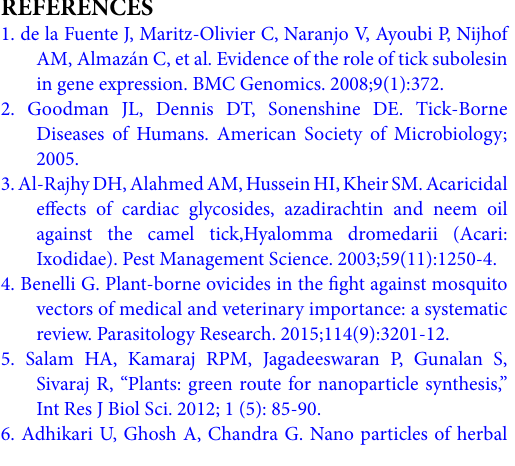
237 Nanomed Res J 4(4): 234-238, Autumn 2019